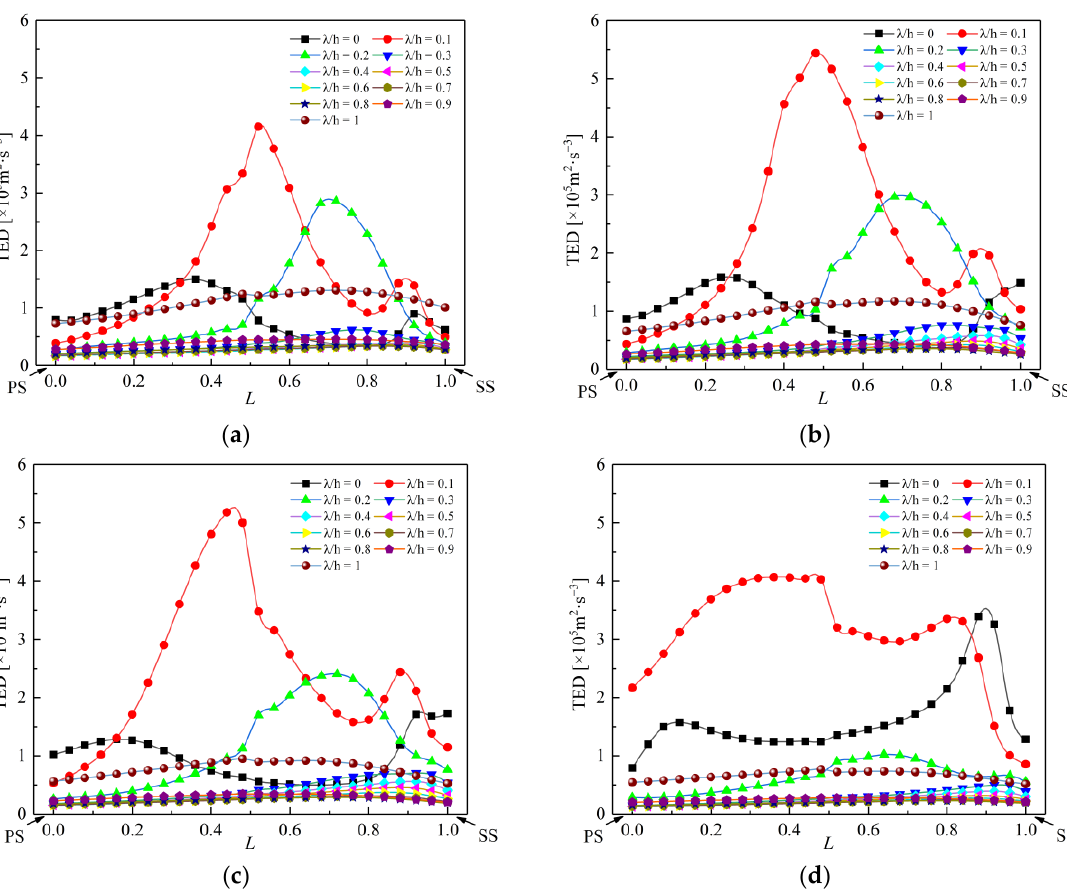
Figure 17. TED in the tip clearance. ( a ) IGVF = 5%; ( b ) IGVF = 10%; ( c ) IGVF = 15%; and ( d ) IGVF = 20%.